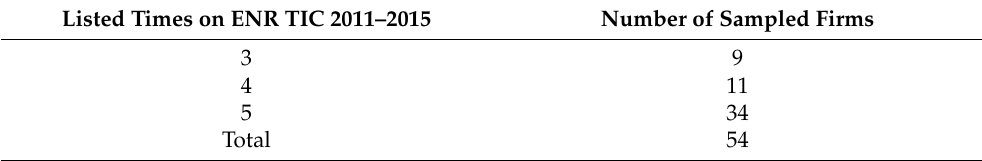
Table 2. The number of sampled Chinese contractors by listed times on ENR TIC 2011–2015. Listed Times on ENR TIC